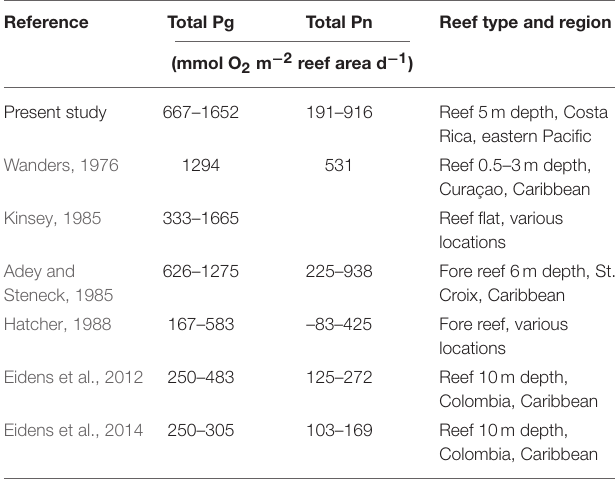
TABLE 3 | Daily total reef primary production in various coral reef